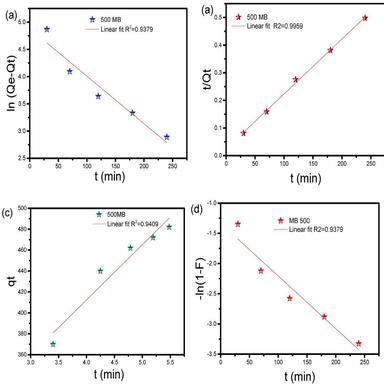
Shows different MB adsorption kinetics models (a) pseudo first order; (b) pseudo second order; (c) Elovich model; and (d) liquid film diffusion.